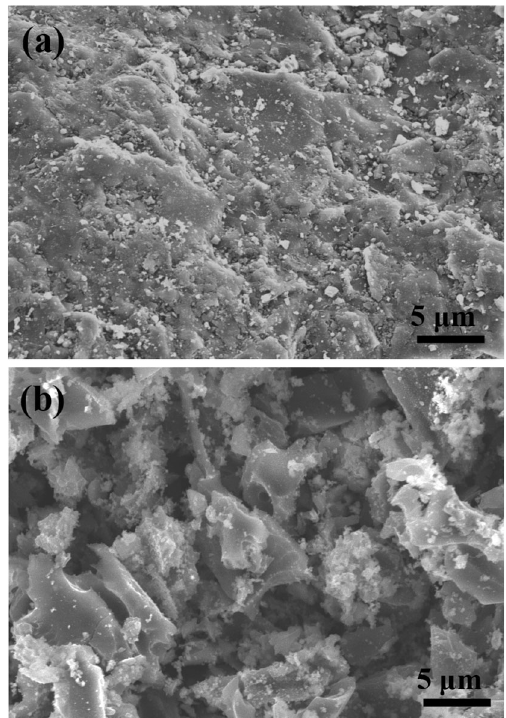
Fig. 4 SEM images of ZD char ( a ) and fly ash ( b